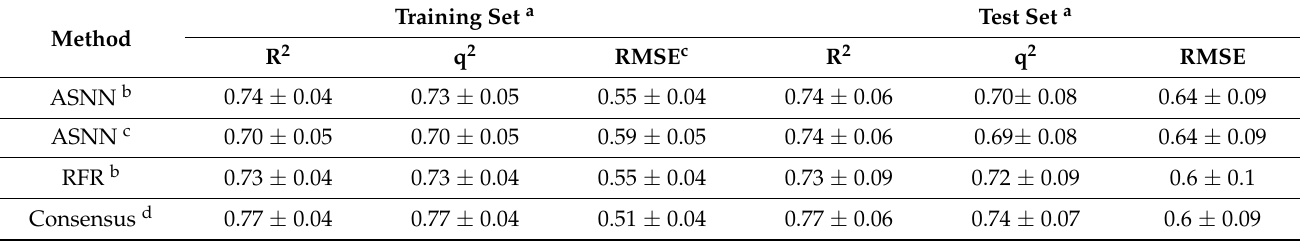
Table 2. Statistical coefficients calculated for QSAR models obtained for dataset II with activity against S. aureus .